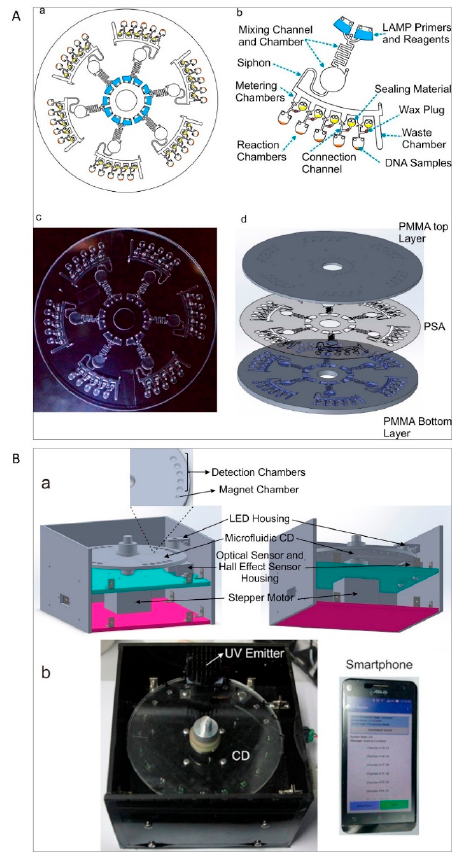
Figure 5. ( A ) (a) Schematic depiction of the centrifugal LAMP microdevice. (b) Top view of one